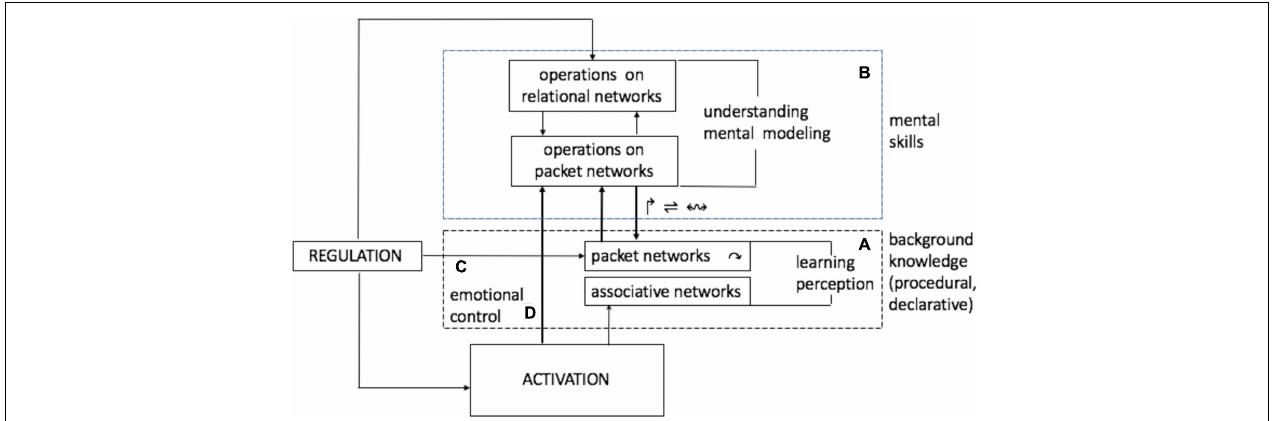
FIGURE 9 | Architectures for understanding. This diagram represents cognition as a regulatory process that is directed at adapting (matching) behavior variations in the organism to condition variations in the world stream and is powered by energy inflows extracted from the stream. Organization in the system comprises different structures submitted to regulation [from tuning receptive fields in individual neurons (Fritz et al., 2003, 2005), to rotating packet vectors, to constructing and manipulating mental models], seeking to stabilize energy inflows while minimizing metabolic costs.